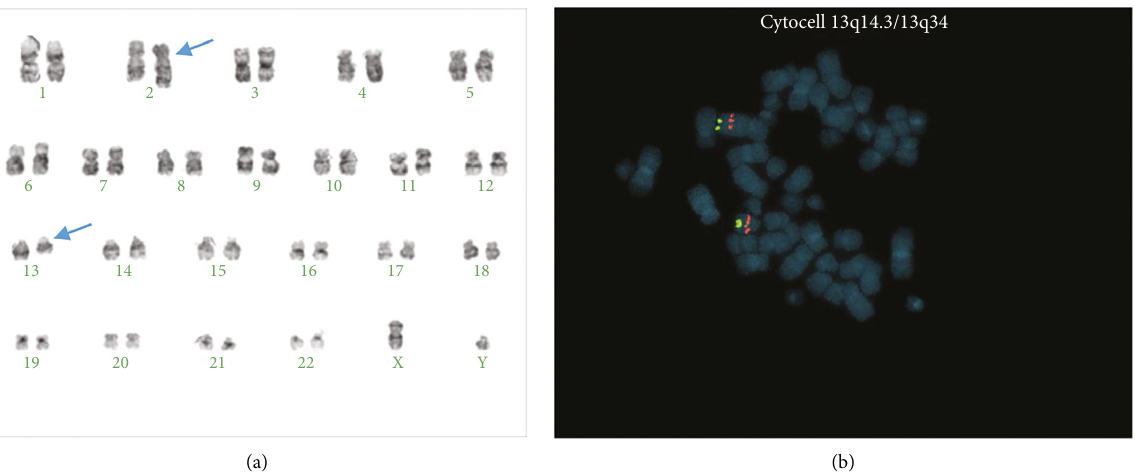
Figure 2: (a) Karyotype images showing t(2;13). (b) FISH image demonstrating the probes for chromosome 13 hybridizing to the normal chromosome 13 (small chromosome) and chromosome 2 (large chromosome), demonstrating the translocation of chromosome 13 material to chromosome